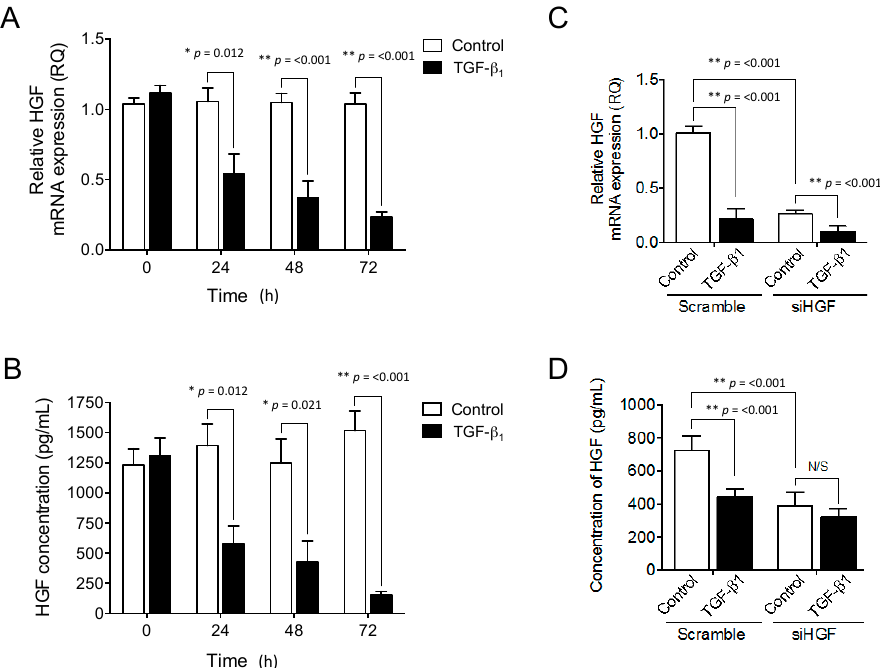
Figure 3. TGF- β 1 supplementation or HGF knockdown inhibit both HGF mRNA expression and protein synthesis. OMFs were maintained in serum-free F-SCM (open bars) or serum-free F-SCM containing TGF- β 1 (10 ng/mL, solid bars), for 72 h. OMF ( A ) HGF mRNA expression and ( B ) HGF protein levels were assessed. OMFs were transiently transfected with either siRNA specific for HGF (siHGF) or a scrambled siRNA. siHGF- and scrambled siRNA-transfected were maintained in serum-free F-SCM (open bars) or serum-free F-SCM containing TGF- β 1 (10 ng/mL, solid bars) for 72 h. The relative extent of HGF expression in siHGF and scrambled control cultures was confirmed by ( C ) RT-qPCR and ( D ) ELISA. RT-qPCR data is shown as mean ± S.E. for n = 6 independent experiments, and ELISA data is displayed as mean ± S.E. for n = 4 independent experiments (* p ≤ 0.05, ** p ≤ 0.01, vs. serum-free F-SCM controls; N/S, no significance).